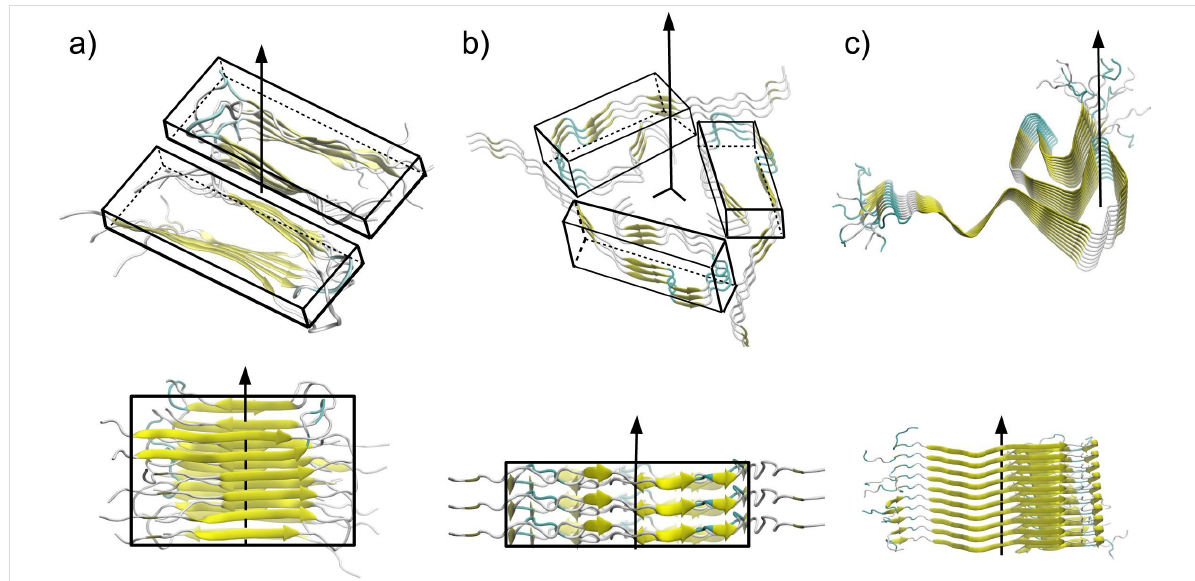
Figure 1: Snapshots illustrating some of the biological fibrils used in our simulation. The main axis of symmetry and the secondary structure for each chain are indicated. (a) A β 40 (PDB ID: 2LMO) with two-fold symmetry. (b) A β 40 fibril (PDB ID: 2M4J) with three-fold symmetry. (c) α -syn fibril (PDB ID: 2N0A) with no symmetry. Rectangular boxes depict the local